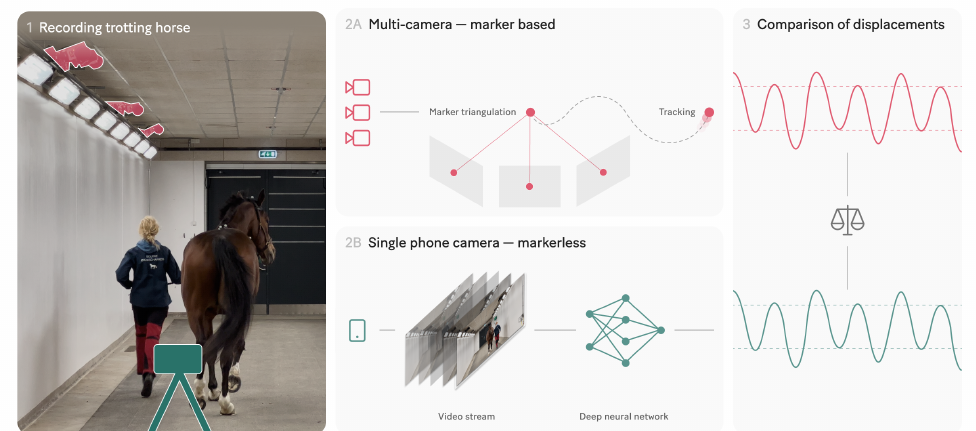
Figure 1. Illustration of the experimental setup. We recorded horses trotting back and forth in a corridor with a multi-camera system and a single smartphone camera. The multi-camera system detected and tracked reflective markers attached to the horse. Marker positions were triangulated into 3D coordinates from which vertical displacement curves were extracted. The single-camera system used deep neural networks to predict the vertical displacement curves of the head and pelvis from the images in the smartphone video stream. We then compared the displacement curves from the two systems using normalised peak and valley differences.